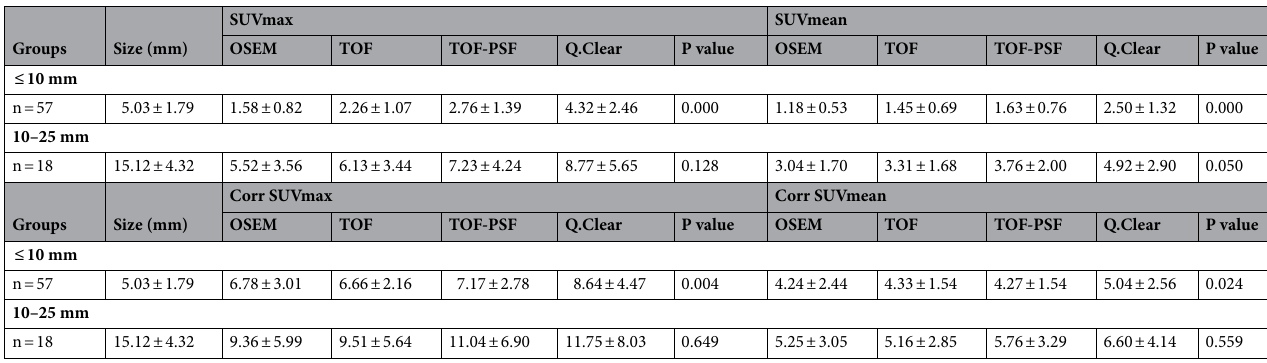
Table 3. The impact of different reconstruction methods on SUVs of small pulmonary nodules before/after PVC. All P values were generated from Kruskal Wallis H test among the four reconstruction